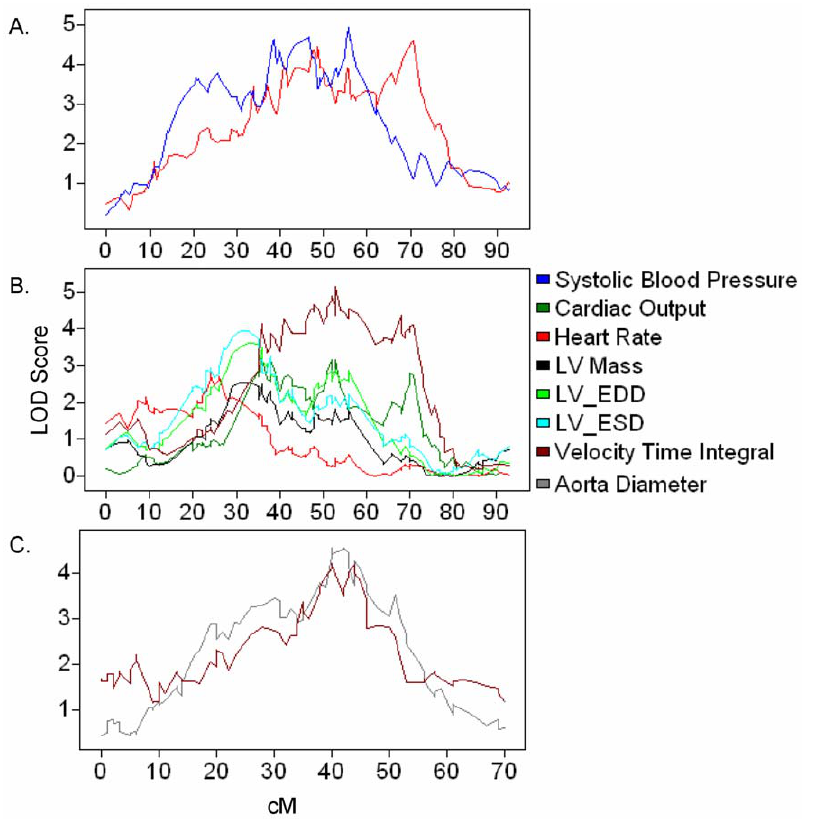
Figure 2. QTLs associated with blood pressure, heart rate, and echocardiography traits highlight different aspects of cardiovascular physiology. QTL plots showing LOD scores by chromosomal position for the indicated traits. (A) locus on chromosome 1 associated with variation in blood pressure and heart rate; (B) locus on chromosome 2 associated with left ventricular anatomy and function and its relationship to cardiac output; (C) locus on chromosome 6 regulating cardiac output parameters associated with aorta diameter.